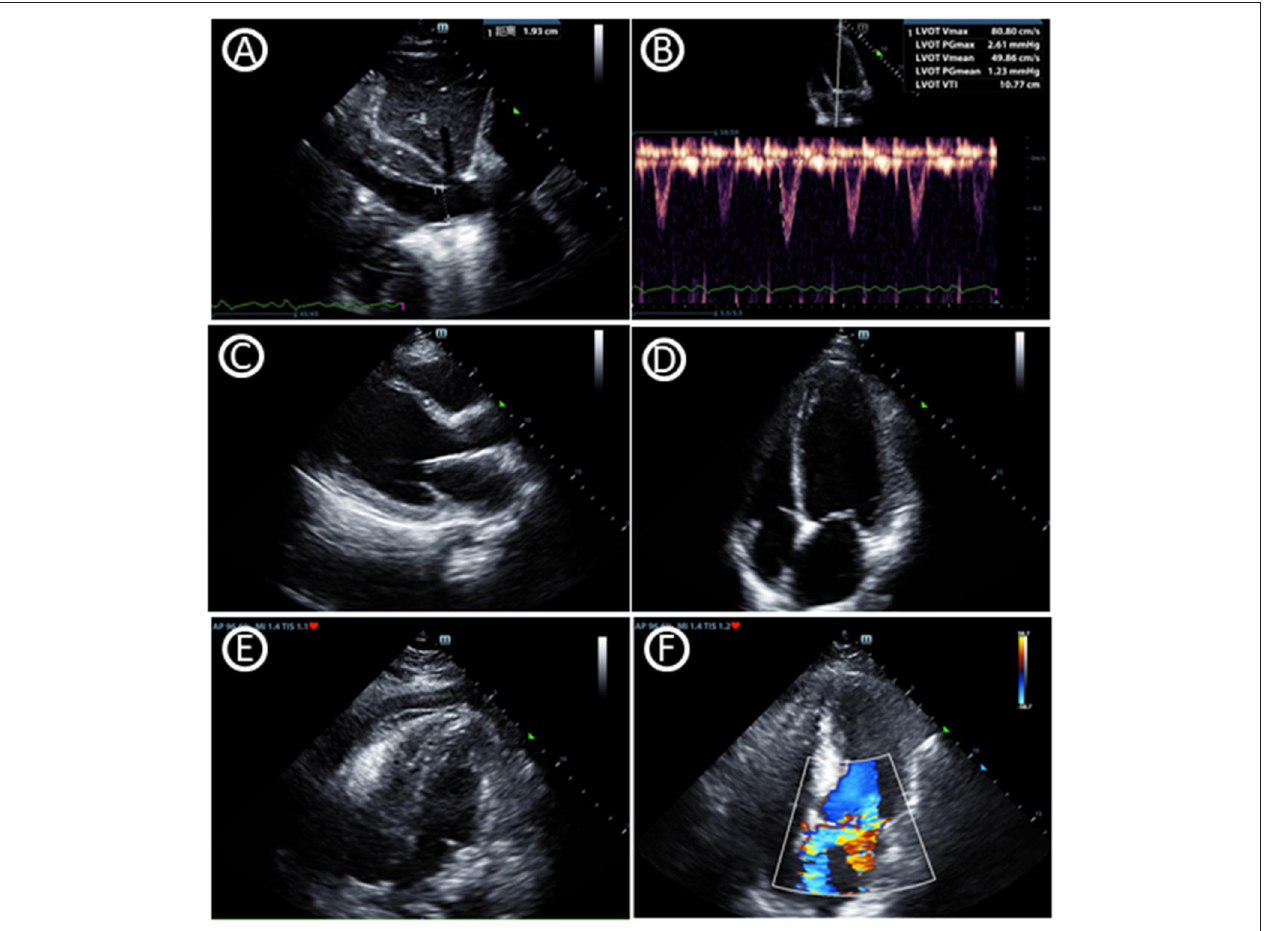
FIGURE 1 | Critical care echocardiography imaging. (A) Inferior vena cava diameter. (B) Velocity-time integral of left ventricular outflow tract, which can help to gain cardiac output and fluid responsiveness. (C) Parasternal window parasternal long-axis view. (D) Apical window four-chamber view. (E) Pericardial effusion in subcostal window four-chamber view. (F) Mitral regurgitation in apical window four-chamber